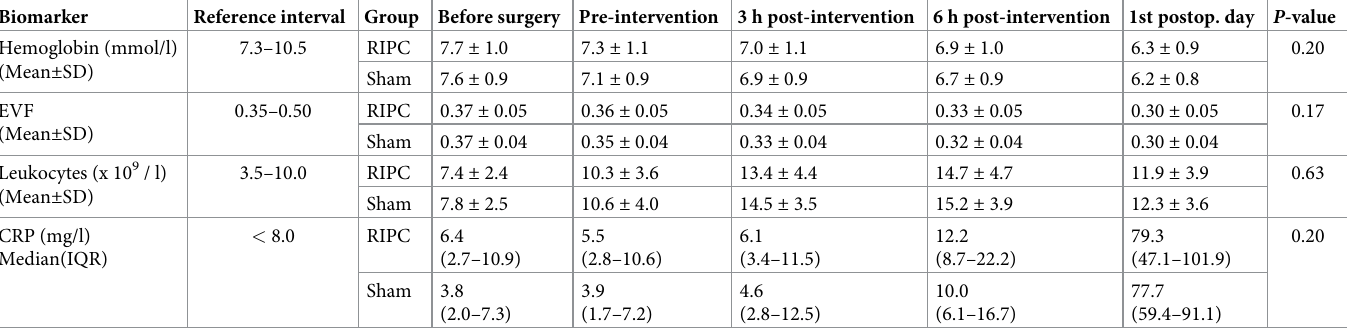
Table 2. Hematology and immunology. Biomarker